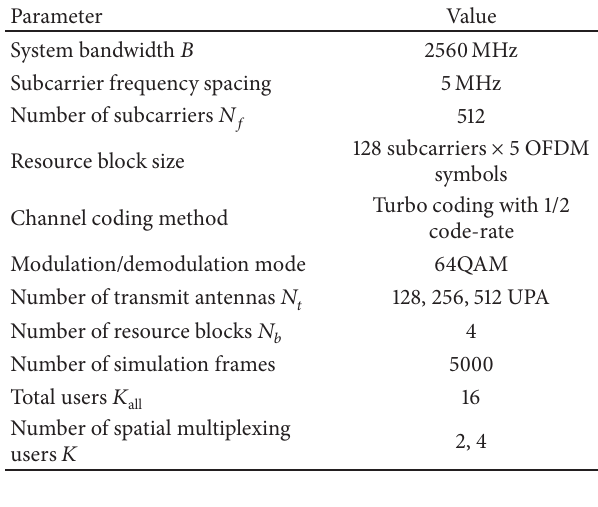
Figure 3: Sum rate versus SNR using the proposed hybrid beam- forming when 𝐾 = 2,4 and 𝑁 𝑡 = 512